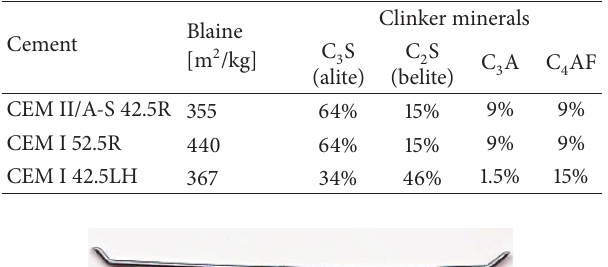
Table 1: The mineral composition of the used types of cement clinker (Bogue).